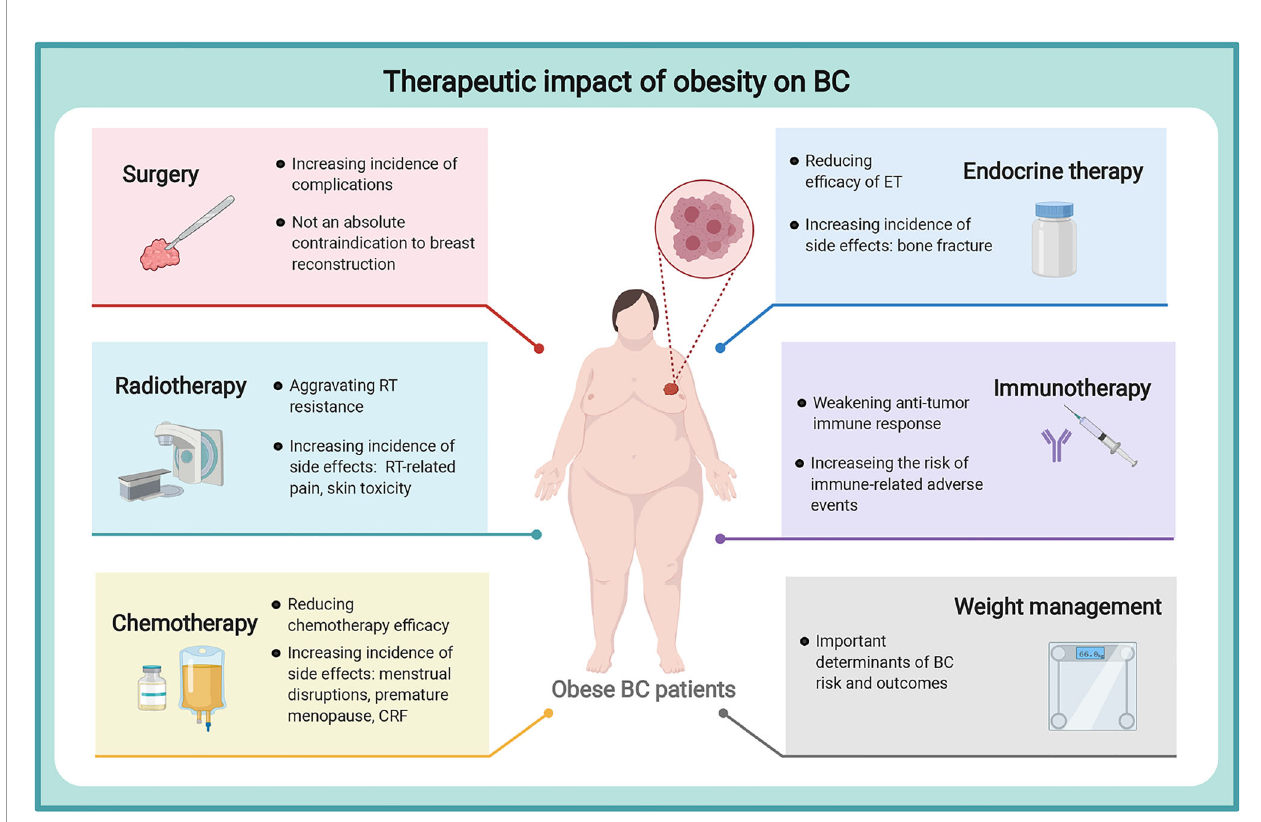
FIGURE 2 | Therapeutic impact of obesity on breast cancer. Obesity could aggravate treatment resistance and potential drug side effects in various BC treatments, including surgery, RT, chemotherapy, ET, immunotherapy, and weight management, posing challenges for the maximum ef fi cacy and minimum side effects of BC therapy. breast cancer, BC, breast cancer; RT, radiotherapy; CRF, cancer-related fatigue; ET, endocrine therapy. The fi gure was created with